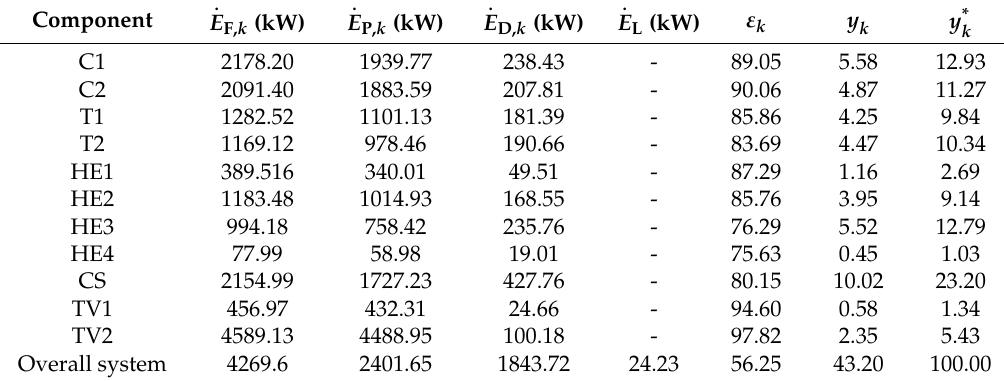
Table 4. Conventional exergy analysis